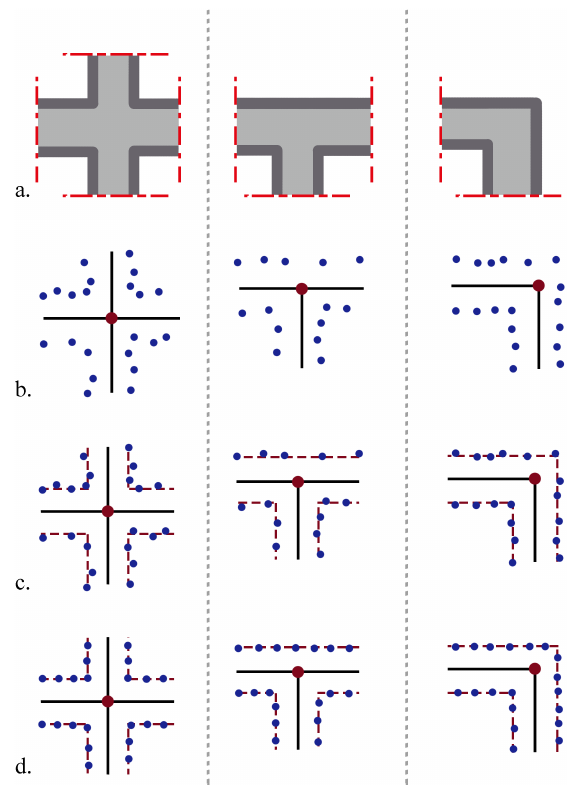
Figure 3. Steps for the regularization of vectorized sidewalk nodes, according to three types of roads crossings (a): X-shape, T-shape, and L-shaped corners. From top to bottom: firstly (b) the type of crossing was identified, then (c) reference lines were computed and then (d) points were slightly moved in order to lie on those lines.